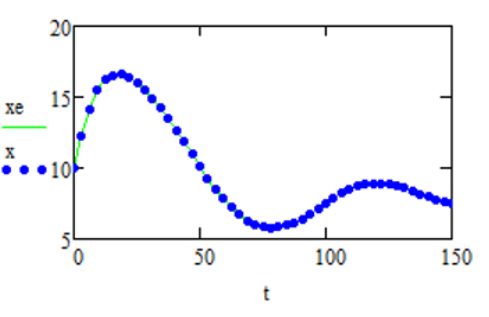
Absolute errors in calculation of x = x ( t ) and y = y ( t ) in the differentiation method for N + 1 = 25 and N + 1 = 49 points are shown in Figure 7 and Figure 8. Performing solution by